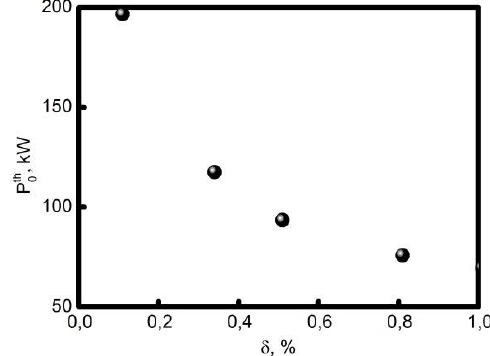
Fig. 2. Dependence of the growth rate on the pump power. The solid curve is defined by the analytical dependence (6). The scattered circles are the results of numerical solution of equation (4). The numerical solution gives an estimate for the 0.094 MW th P  at 0.5%  , 2 cm w  power threshold of 0 and the same parameters of the coupled waves as in figure 1.